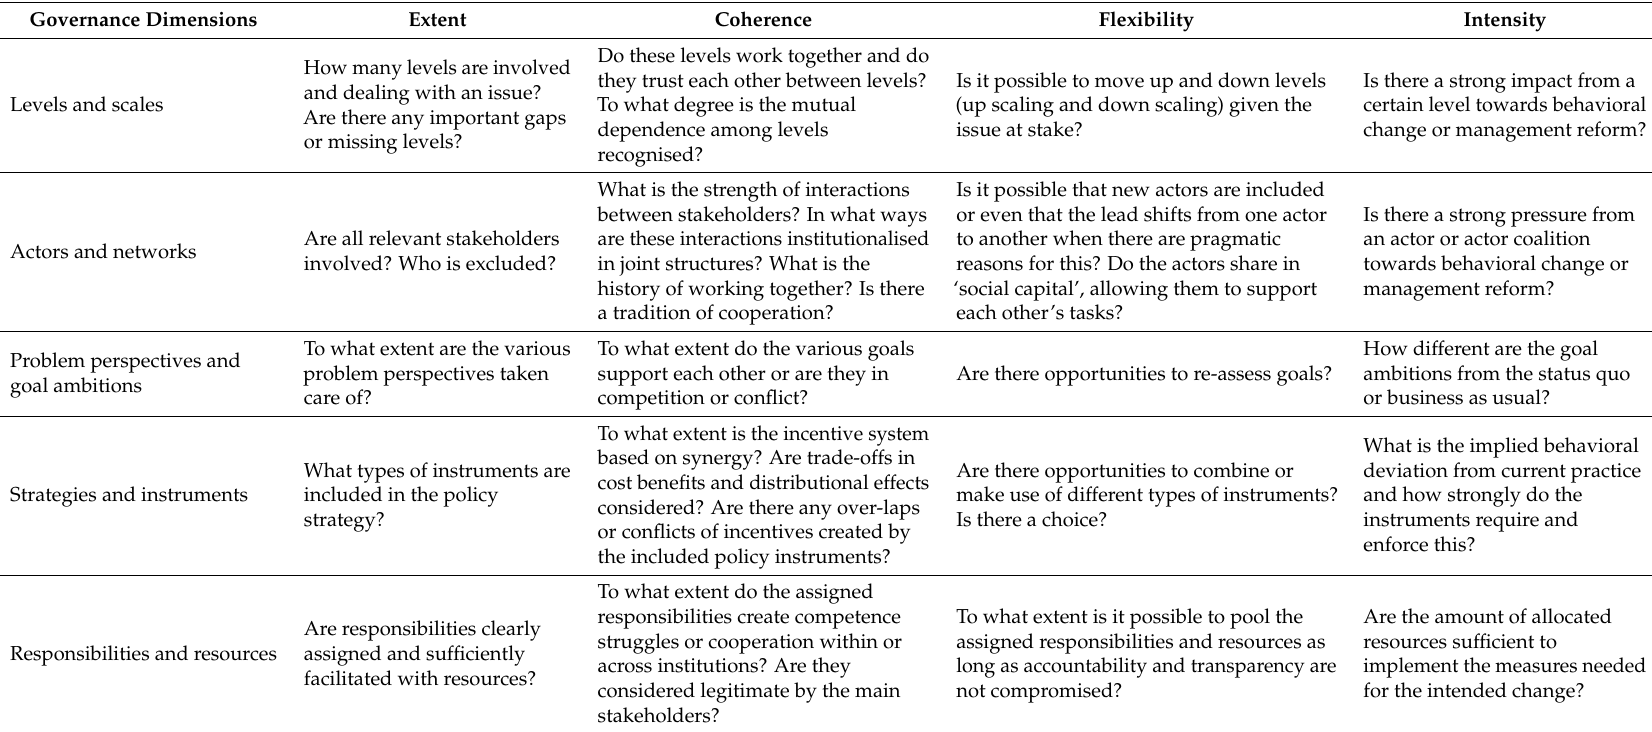
Table 1. Issue matrix of the Governance Assessment Tool (adapted from: Bressers, Bressers, Kuks, Larrue [37], with permission of Springer, 2016). Governance